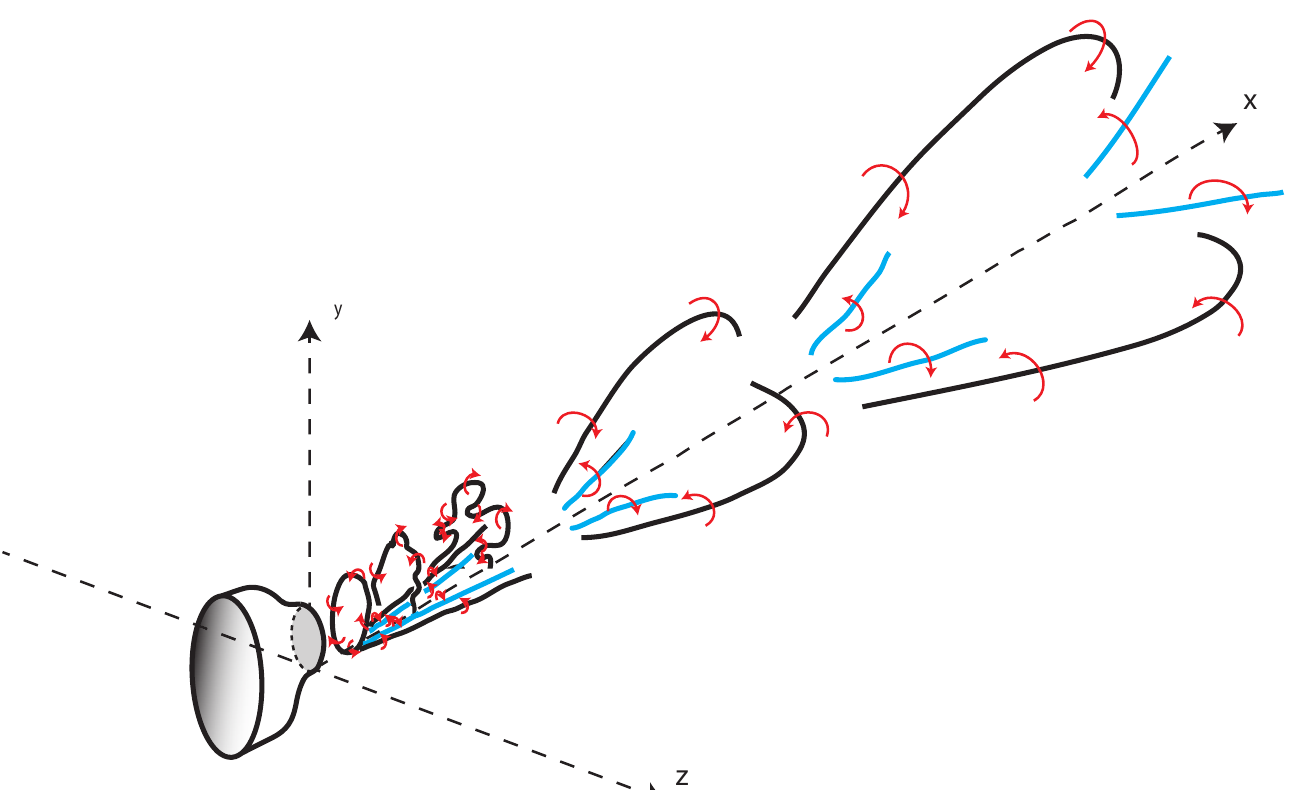
Figure 10. Proposed structural model of the turbulent three-dimensional wall jet exiting from a contoured